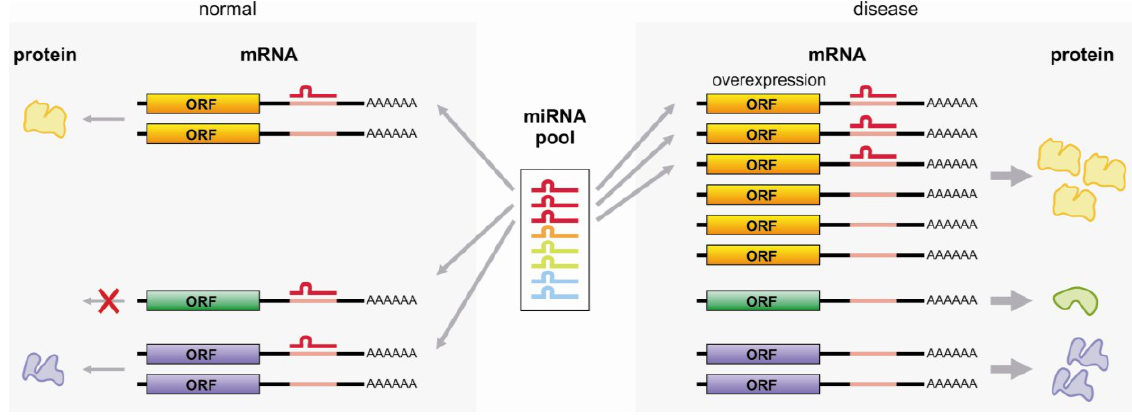
Figure 2. miRNA sponge function for mRNA. In a normal cell, a specific miRNA can target a number of mRNAs resulting in the inhibition of translation and/or degradation of these transcripts. When the expression levels of one of the mRNAs targeted by this miRNA is changed, a redistribution of the specific miRNA will cause a change in protein translation for multiple transcripts. In this schematic figure, the overexpressed yellow mRNA functions as a sponge for the red miRNA, yielding increased green and blue protein levels. In contrast, a depletion of the yellow miRNA sponge would result in a decrease in green, blue and yellow protein